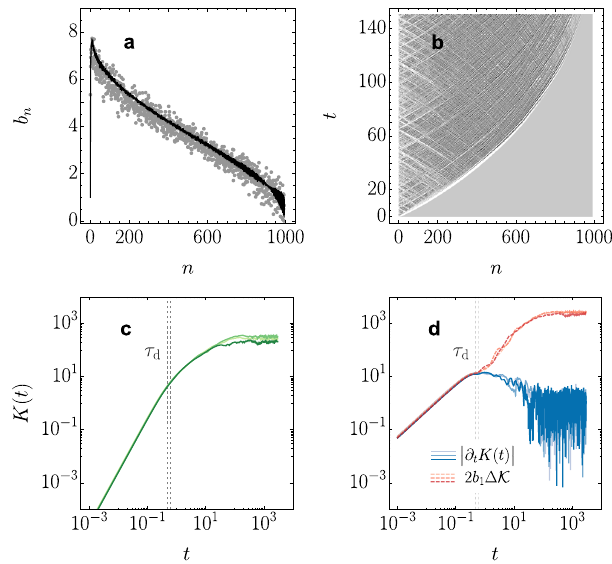
Fig. 2 Growth of Krylov complexity in a generic system. a Squares of the Lanczos coef fi cients for a single realization (gray points) and an average over 100 random Hamiltonian matrices (black line). b Operator growth in the Krylov lattice as displayed by the dynamics of the amplitudes ∣ φ n ( t ) ∣ 2 for a single random matrix realization. c Krylov complexity (green solid lines) together with the deviation time (gray dashed line) for three independent random matrix realizations. d The corresponding absolute value of the growth rate of the Krylov complexity (blue solid lines), together with the dispersion bound (red dashed lines), Eq. (2). In all fi gures, the random Hamiltonian matrices are sampled from GOE( d ) with standard deviation σ = 1, maximal Krylov dimension D = 993 and a uniform initial observable operator O 100 different Hamiltonians of dimension d = 32, sampled from GOE( d ) with standard deviation σ = 1. Operator growth is displayed by the time-dependent amplitudes, which are found by